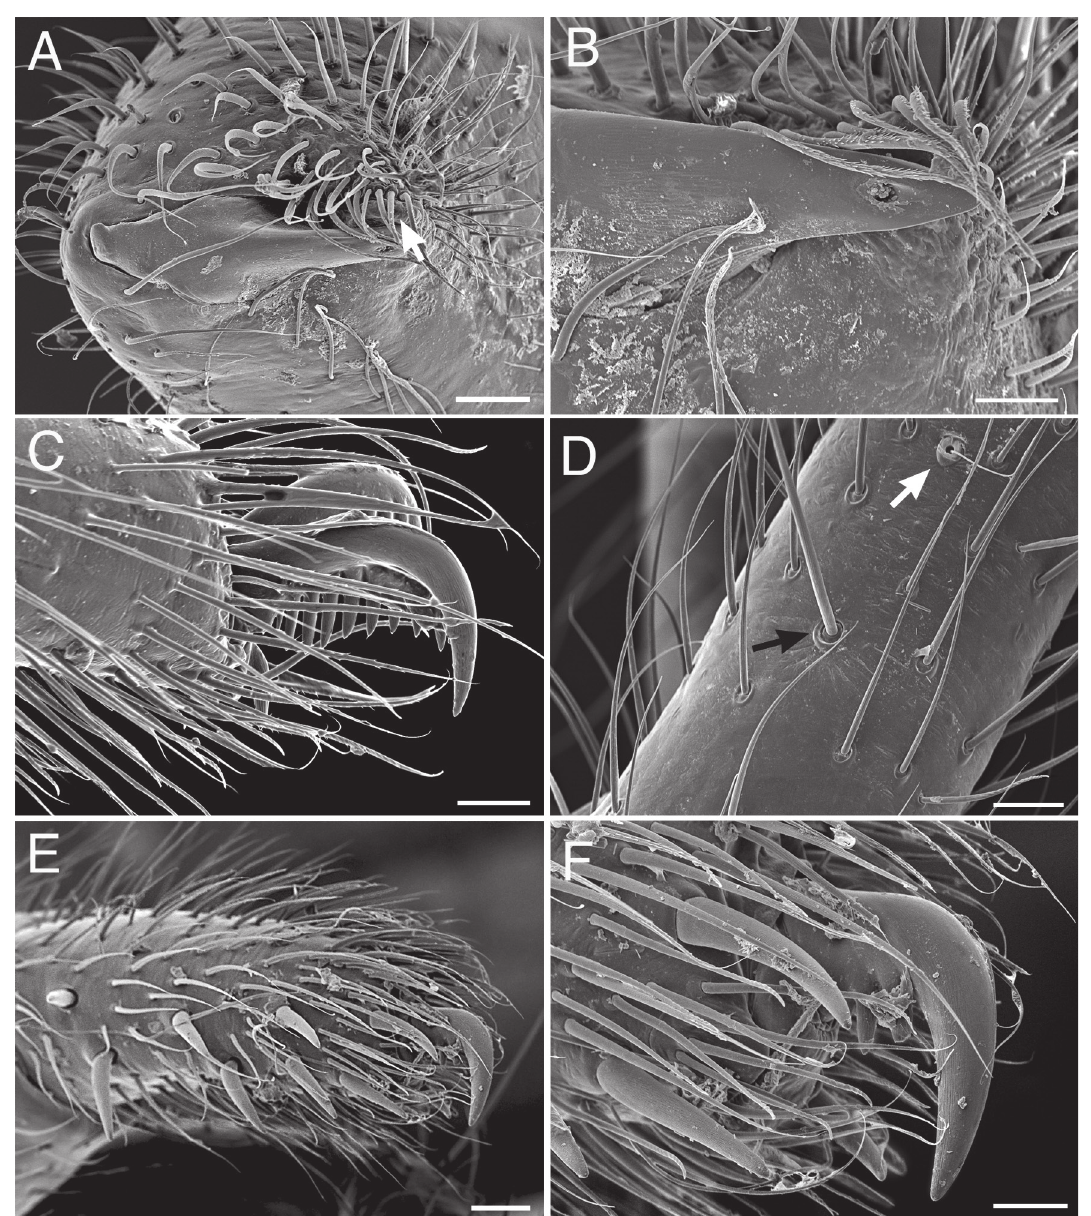
Fig. 1. Palindroma morogorom gen. et sp. nov. Scanning electron miocrographs. A–D. ♂ from Kigogo Reserve. E–F. Paratype ♀. A . Right chelicera, ventral view, arrow shows membranous lamina. B . As previous, detail. C . Leg I, tarsal claws, lateral view. D . Tibia I, hinged hair (black arrow), trichobothrium (white arrow). E . ♀ right palp, lateral view. F . detail of previous. Scale bars: A, e–F = 100 mm, B–d = 50